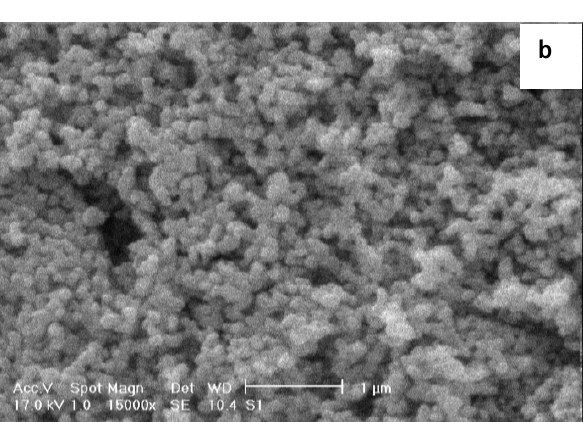
(1,4-bdc) (dabco)]· 2 2